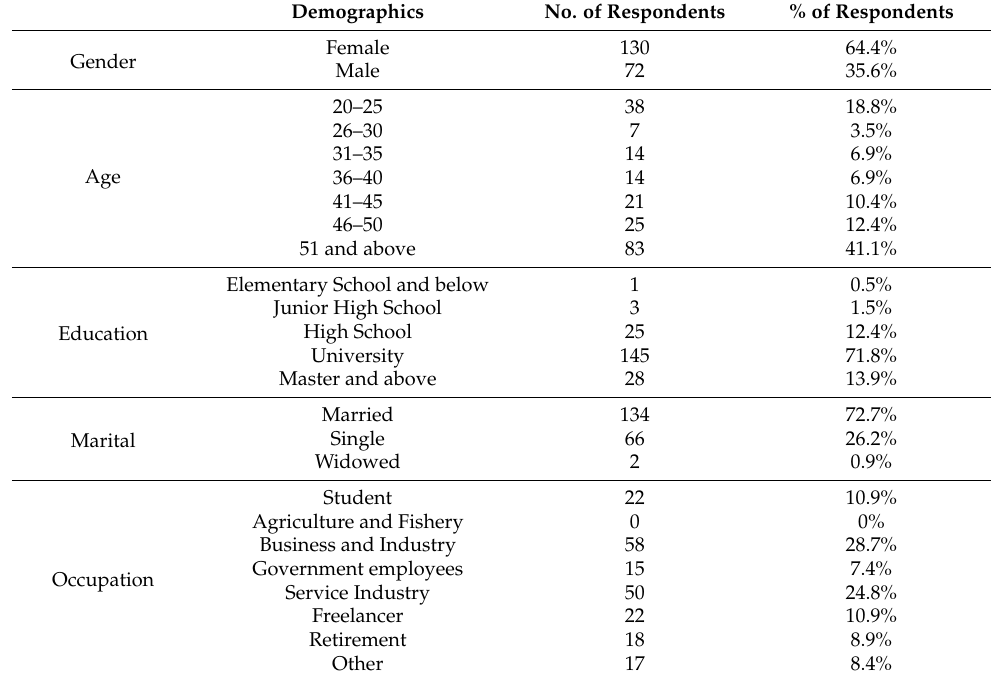
Table 7. Descriptive statistics of